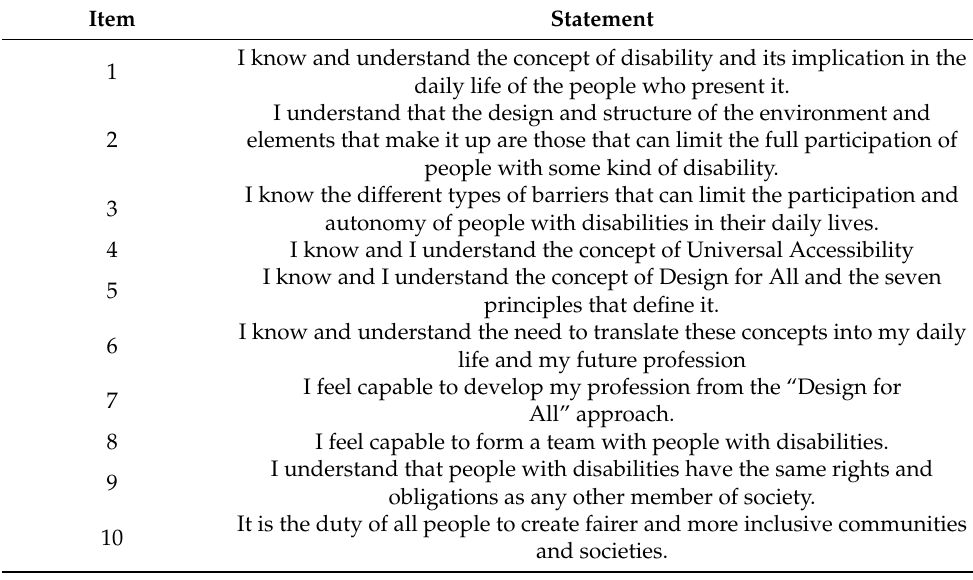
Table 1. Questionnaire’s items used for data collection and pre- and post-training